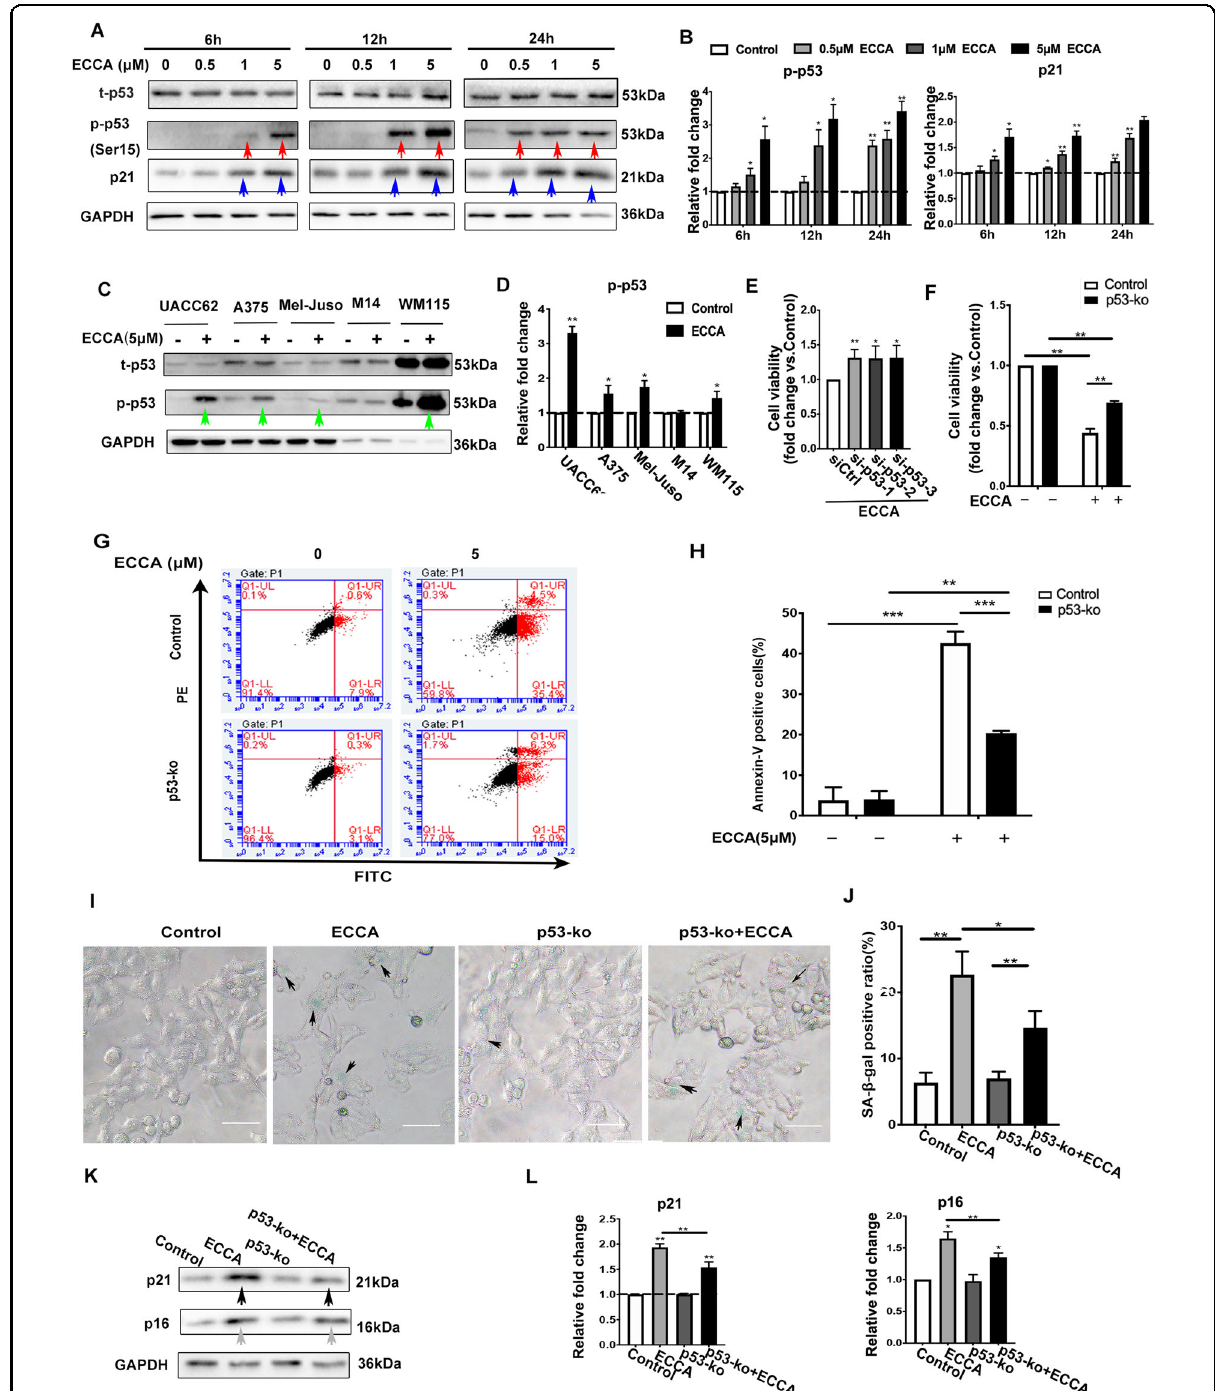
against MAPKs. Treatment with ECCA clearly